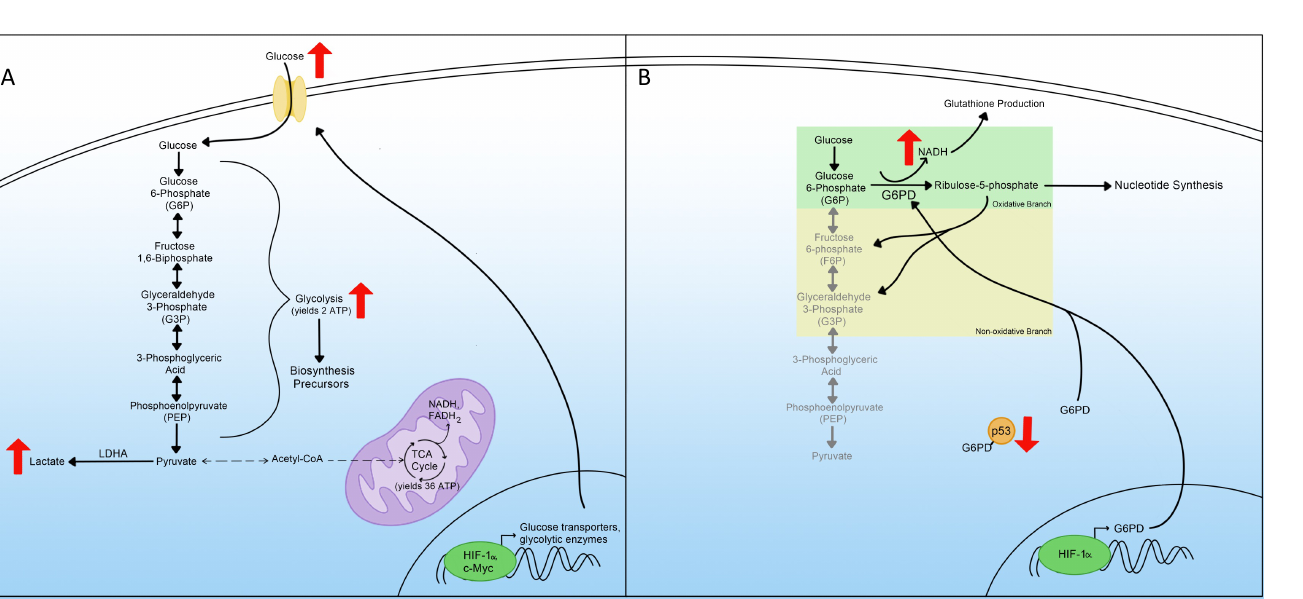
Figure 2. Glycolysis and the pentose phosphate pathway in metabolic reprogramming. ( A ) Upregu- lated glycolysis in metabolic reprogramming including the transcriptional regulation and increased expression of glucose transporters as well as the consequences of increased glycolysis. ( B ) Mecha- nisms leading to pentose phosphate pathway (PPP) upregulation during metabolic reprogramming include both branches and transcriptional regulation of critical